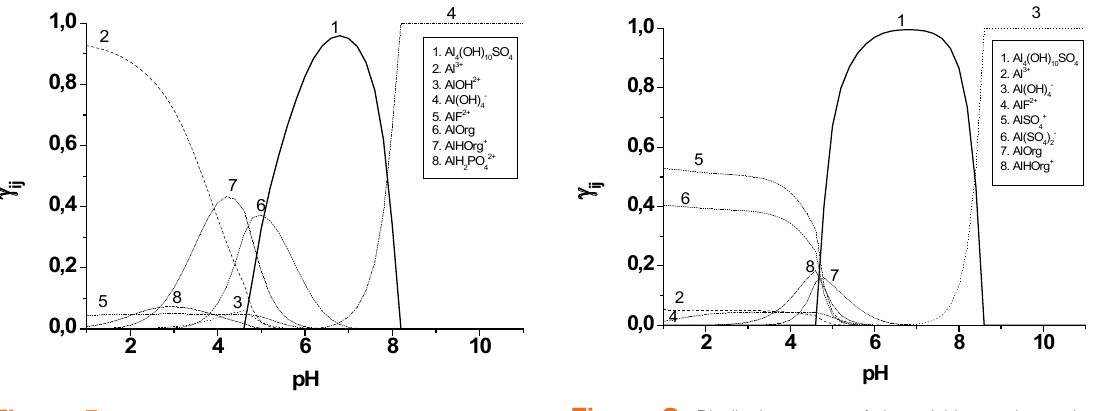
Figure 5. Distribution curves of the soluble species and solid phase in the system „basaluminite – saturated aqueous solution” for